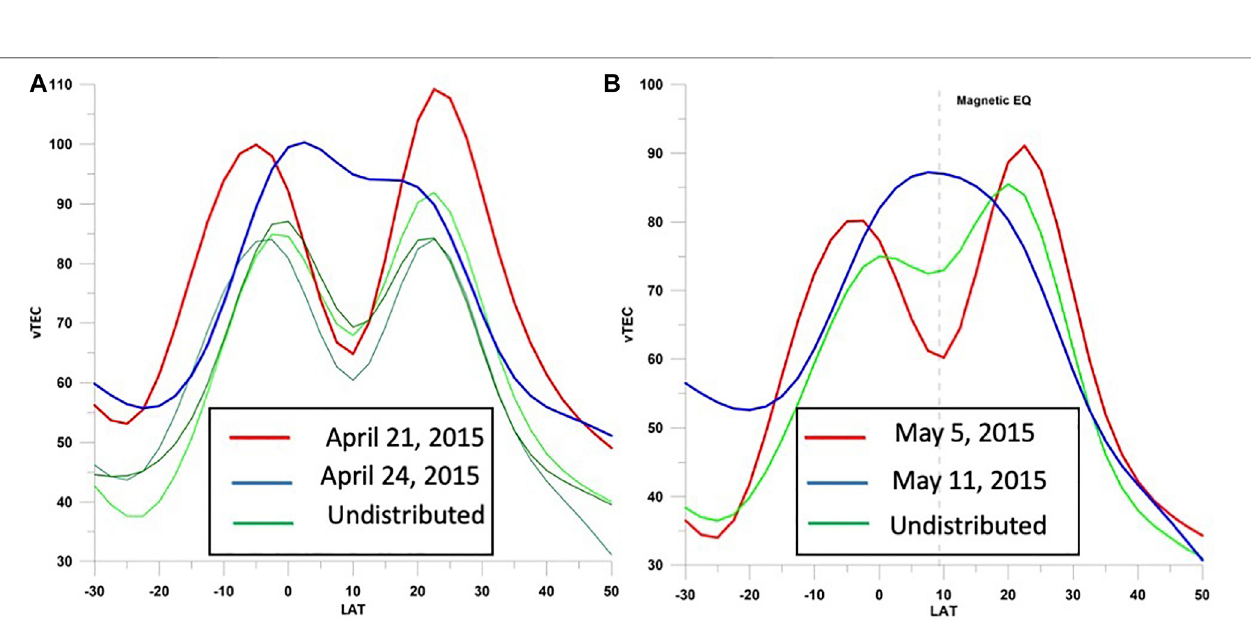
FIGURE 9 | dTEC variations (de fi ned in Eq. 3 ) for the lhaz GPS/GLONASS receiver ( Figure 1 ) for April 6 – May 15, 2015.